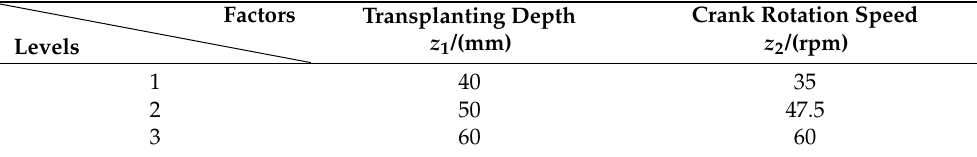
Table 1. Experimental factors and levels.